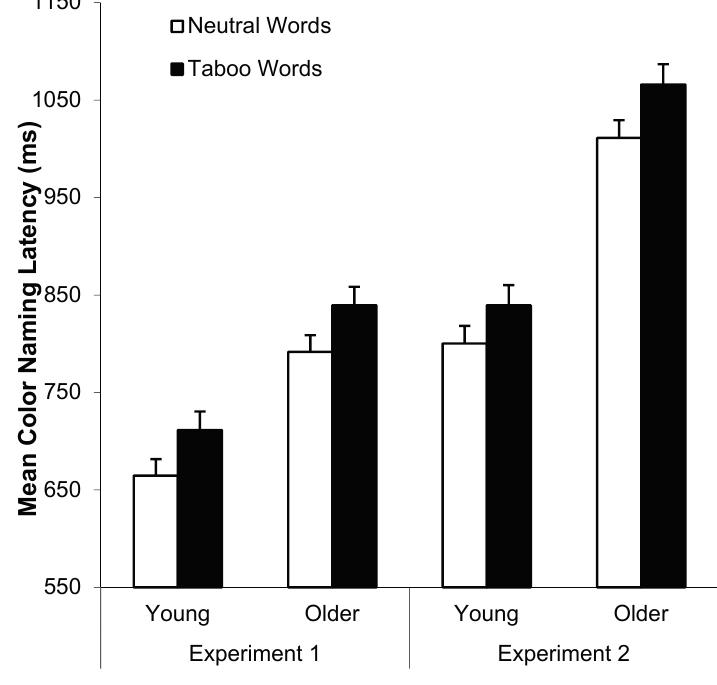
Figure 3. Mean color-naming RTs (+ SE ) as a function of age and word type in Experiments 1 (left panel) and 2 (right